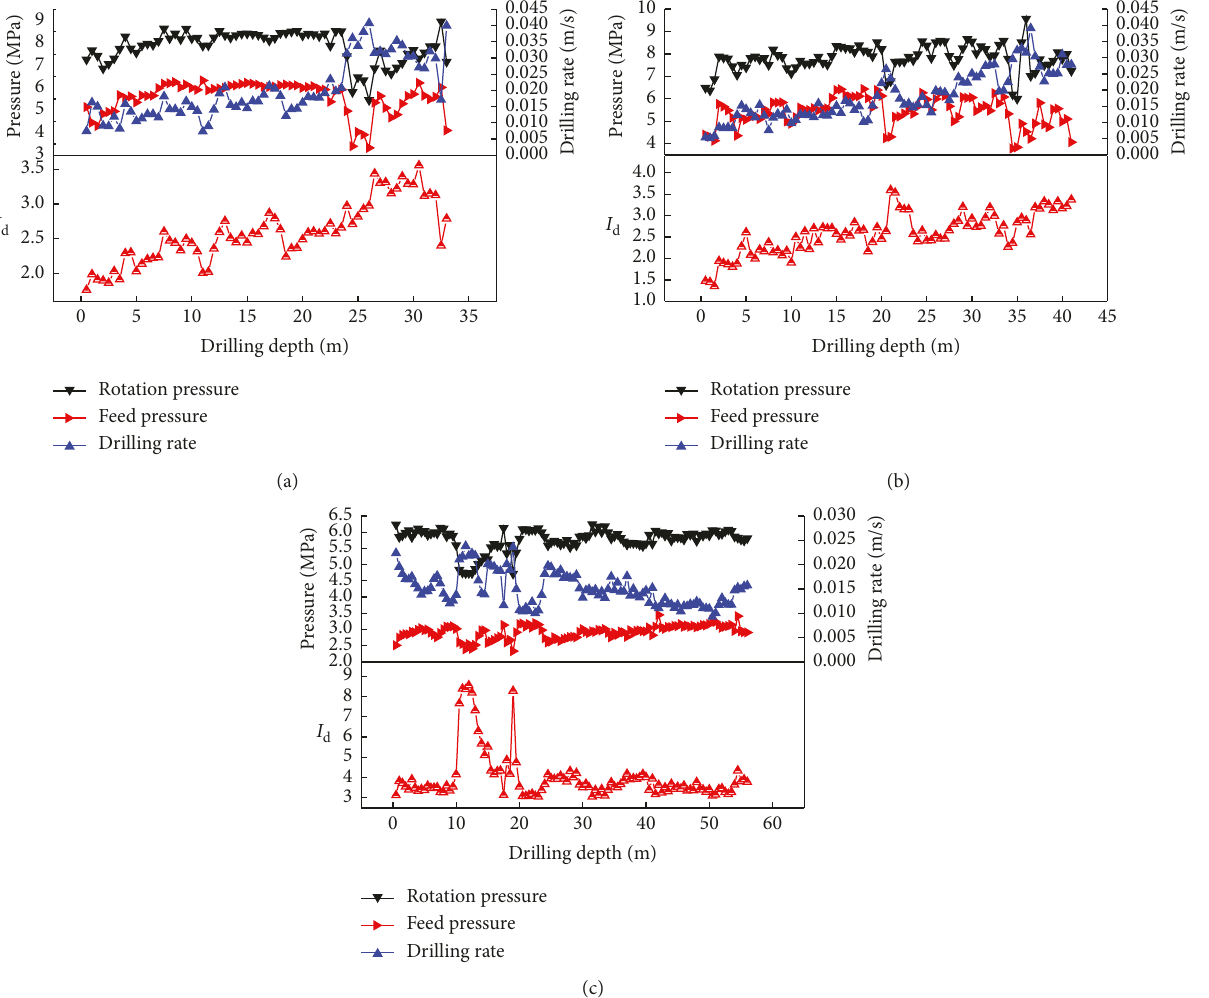
Figure 11: Curves of index I d of different boreholes: (a) results of cross-layer borehole No. 11; (b) results of cross-layer borehole No. 12; (c) results of in-seam borehole No.